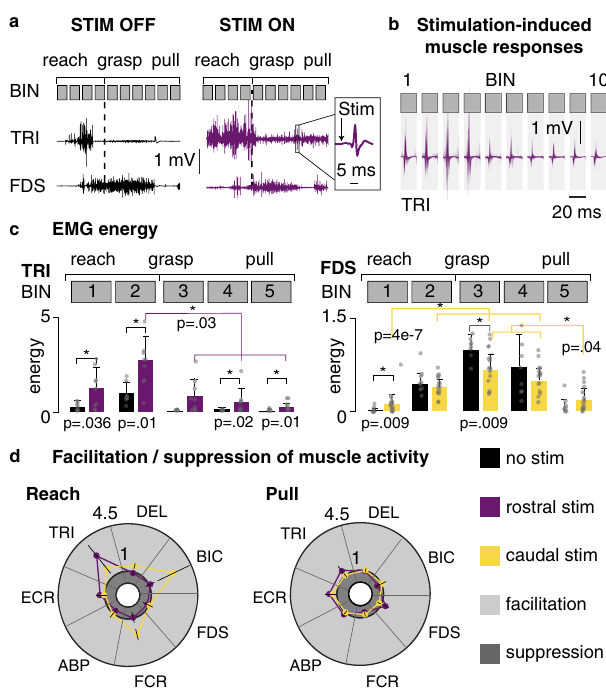
Fig. 8 Effects of continuous stimulation during voluntary movement. a Example of EMG activity during a reach, grasp and pull task. Left: without stimulation. Right: with stimulation. Top gray squares: division of time into 10 equal bins (used in b ). Inset: typical stimulation-induced muscle response. TRI: triceps. FDS: fl exor digitorum super fi cialis. b Overlay of stimulation-induced muscle responses in the triceps muscle during task execution. For multiple task executions (each divided in 10 bins as in a ) and for each bin, the 20 ms windows of EMG data following each stimulation pulse occurring in the bin were extracted and overlaid (301 superimposed responses per bin). c EMG energy of the TRI (left) and FDS (right) muscles during task execution. Black: without stimulation. Purple: with rostral stimulation. Yellow: with caudal stimulation. Bars and whiskers: mean and standard deviation of the EMG energy across multiple task executions (rostral stim: 9 trials; caudal stim: 16 trials; baseline: 9 trials). For each